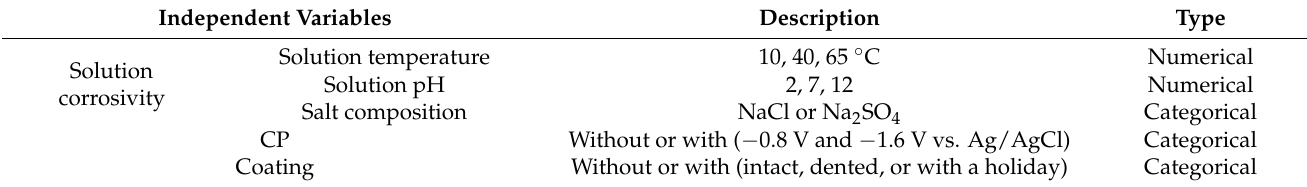
Table 2. Independent parameters studied (either numerical or categorical